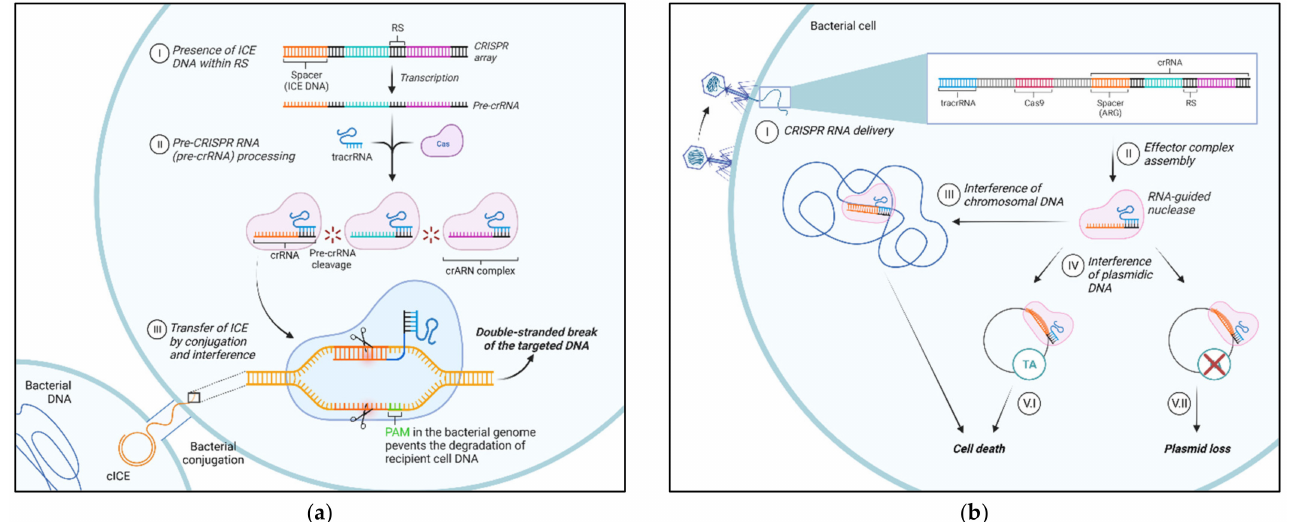
Figure 4. Possible clustered regularly interspaced short palindromic repeats (CRISPR)-based ap- proaches to limit the spread of antimicrobial resistance. ( a ) Conjugation blockage: (I) integrative and conjugative element (ICE) DNA fragments (spacers) are present in the bacterial genome in between the repeated CRISPR sequences (RS) as a consequence of spacer acquisition from previous ICE exposure; (II) trans-activating CRISPR RNA (tracrRNAs) recognize CRISPR RNA (crRNA) sequences (pre-crRNA); one or more Cas proteins process the long pre-crRNA into individual RNA, called guide ARN or crARN, which forms a complex with one or more Cas proteins; (III) when the bacterium receives the same ICE by conjugation, the crRNA complex recognizes protospacer adjacent motif (PAM) motifs leading to target invading DNA recognition and Cas-mediated cleavage ( b ) Targeting antimicrobial resistance genes: (I) The RNA-guided nuclease (RGN) construct is delivered inside the targeted bacteria by a bacteriophage; (II) CRISPR locus is transcribed and processed into crRNAs, that together with tracrRNA and Cas proteins, form the RGN; (III) when the targeted DNA sequence is present in the bacterial chromosomal DNA, the RGN activity is cytotoxic; (IV) when the targeted DNA sequence is present in the bacterial plasmid DNA, there are two possible outcomes depending on the presence/absence of toxin-antitoxin (TA) systems; (V.I) TA system is present: the RGN activity is cytotoxic; (V.II) TA system is absent: the RGN activity leads to plasmid loss and resensitization the bacterial cell. cICE, circular ICE. Created with